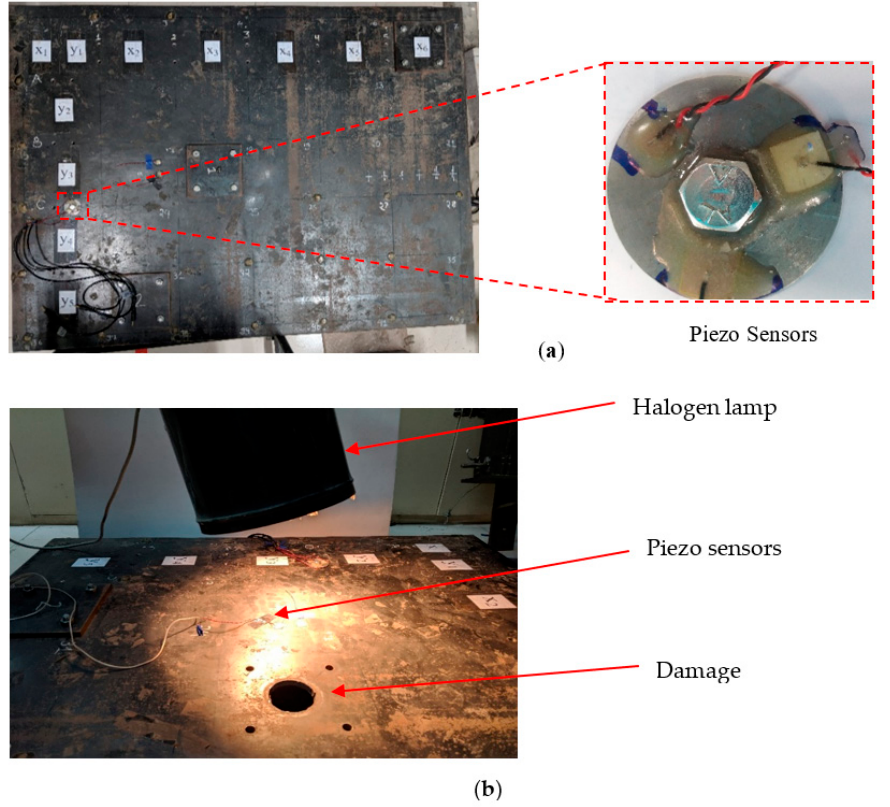
Figure 16. Experimental prototype structure: ( a ) steel plate with piezo sensors, ( b ) prototype structure with halogen lamp and damage.